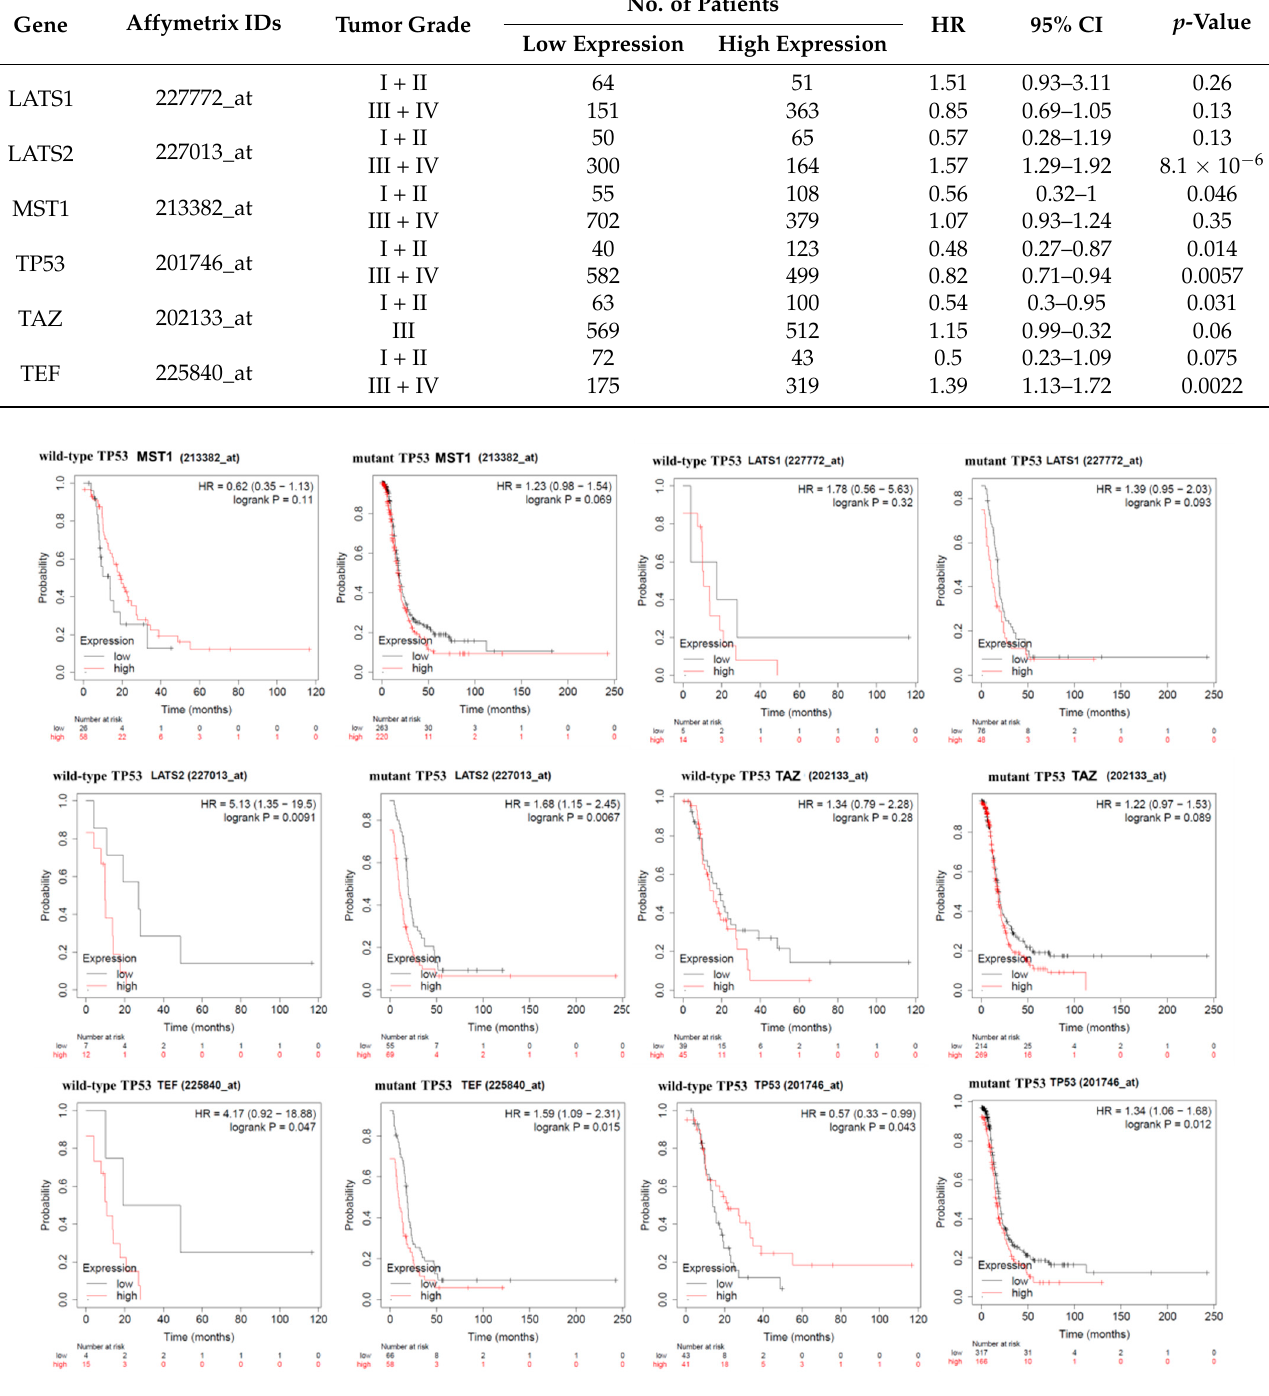
Figure 4. Progression-free survival (PFS) subgroup analysis of key Hippo signaling genes for OC patients, according to high or low expression level based on TP53 status. PFS analysis of key Hippo signaling genes (MST1, LATS1, LATS2, TAZ, MST1, and TEF) for OC patients separated on TP53 status. PFS survival curve of OC patients according to the expression of Kaplan–Meier plotter (https://kmplot.com/analysis/index.php?p=service, accessed on 4 January 2021) based on TCGA patients, a log-rank test was used for TP53 mutated and TP53 wild-type (LATS1 high/low, wild-type TP53 p = 0.32 and mutant TP53 p = 0.093; TP53 high/low, wild-type TP53 p = 0.03 and mutant TP53 p = 0.012; LATS2 high/low, wild-type TP53 p = 0.0091 and mutant TP53 p = 0.0067; TAZ high/low, wild-type TP53 p = 0.26 and mutant TP53 p = 0.89; MST1 high/low, wild-type TP53 p = 0.11 and mutant TP53 p = 0.69; TEF high/low, wild-type TP53 p = 0.047 and mutant TP53 p = Table 2. Correlation of key Hippo genes with PFS according to tumor grade, hazard ratio, and 95% confidence interval. Gene